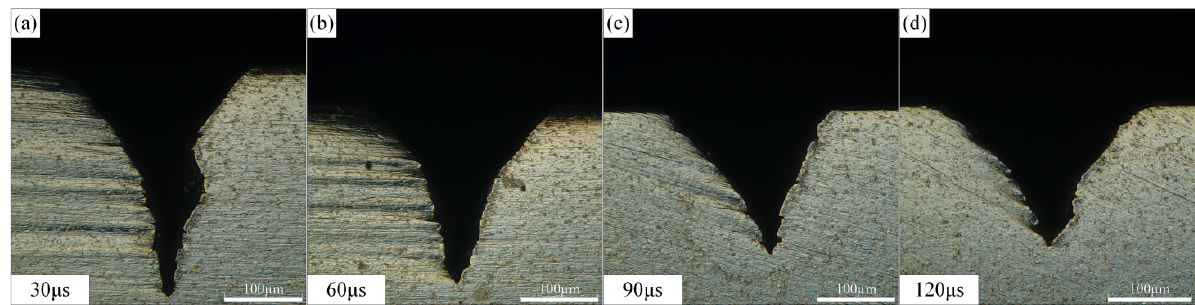
Figure 9. Effect of laser pulse width on microgroove morphology. ( a ) Laser pulse is 30 µ s, ( b ) Laser pulse is 60 µ s, ( c ) Laser pulse is 90 µ s, ( d ) Laser pulse is 120 µ s.